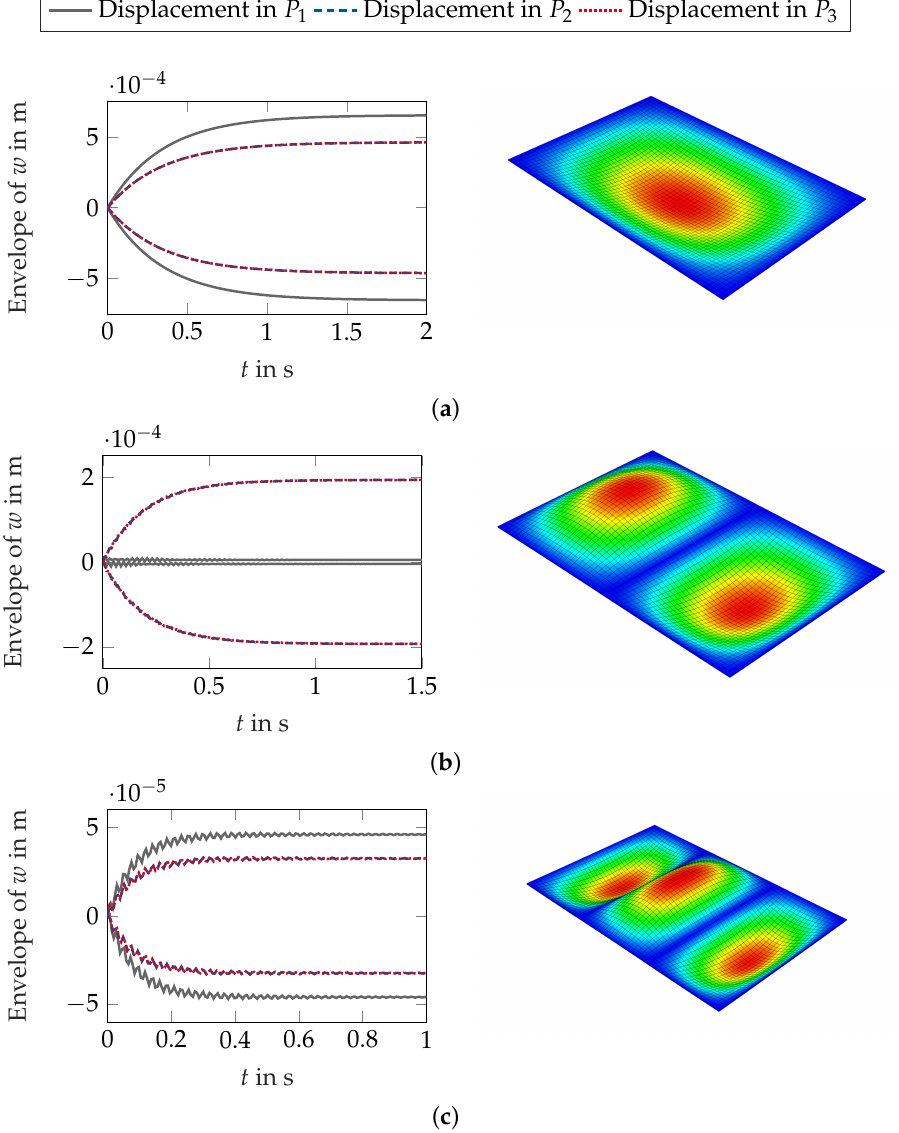
Figure 6. Envelope of the lateral displacement w in points P 1 to P 3 and vibration shapes for different excitations: ( a ) Excitation in P 1 with 44 Hz; ( b ) Excitation in P 2 with 85 Hz; ( c ) Excitation in P 1 with 153